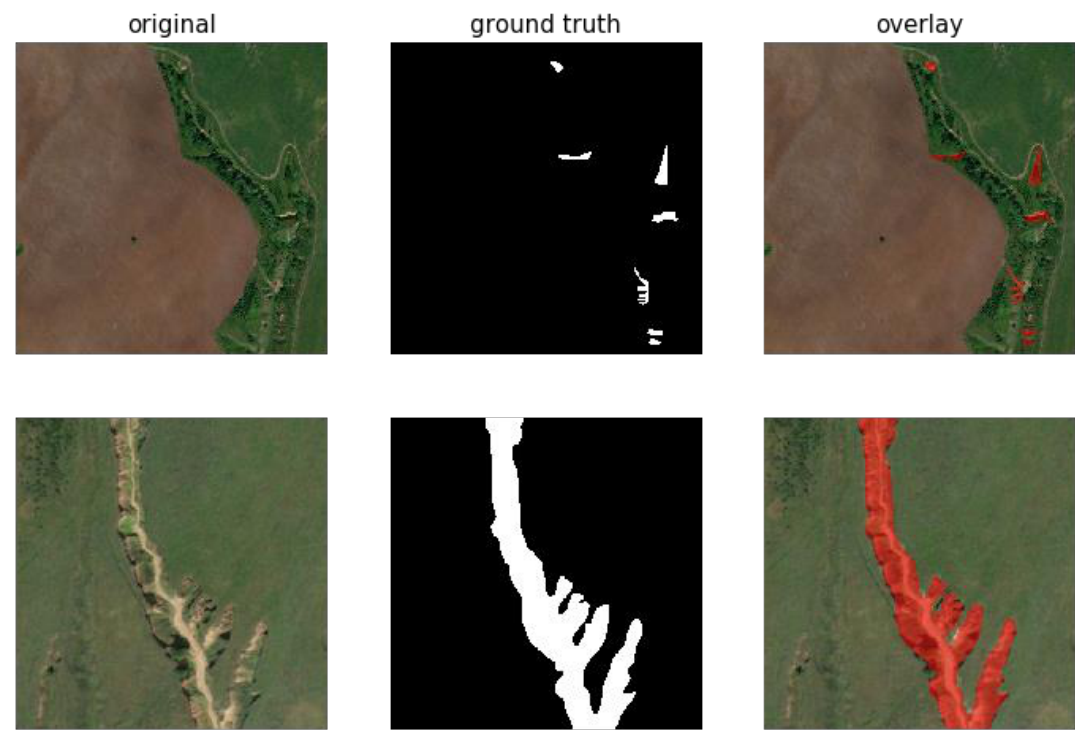
Figure 4. Example of the initial training dataset. Remote Sens. 2020 , 12 , x FOR PEER REVIEW